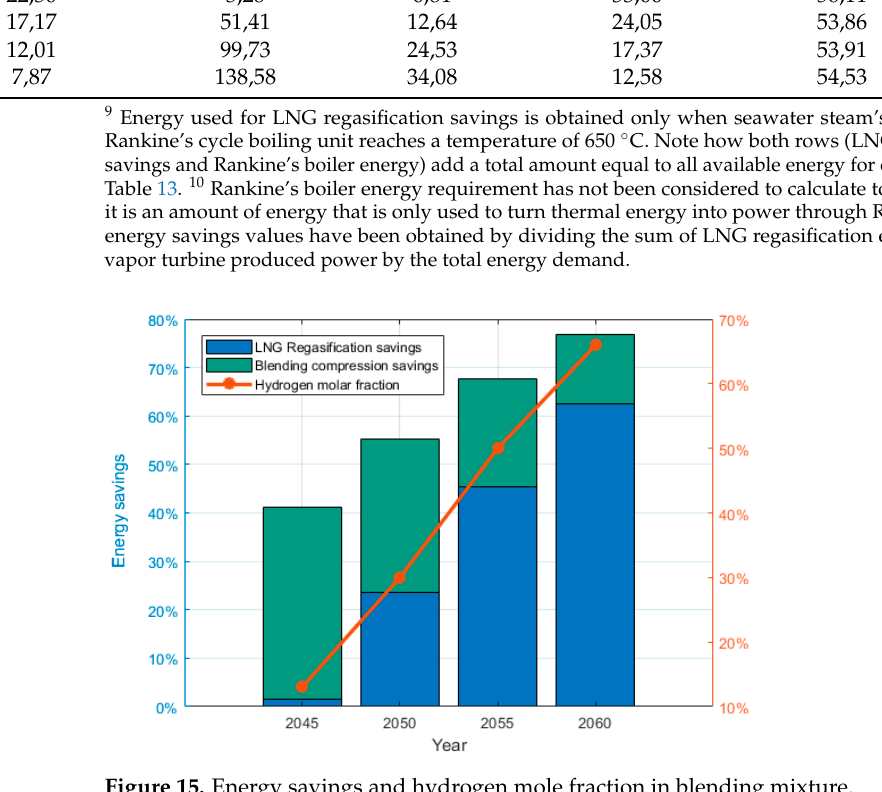
Figure 15. Energy savings and hydrogen mole fraction in blending mixture.